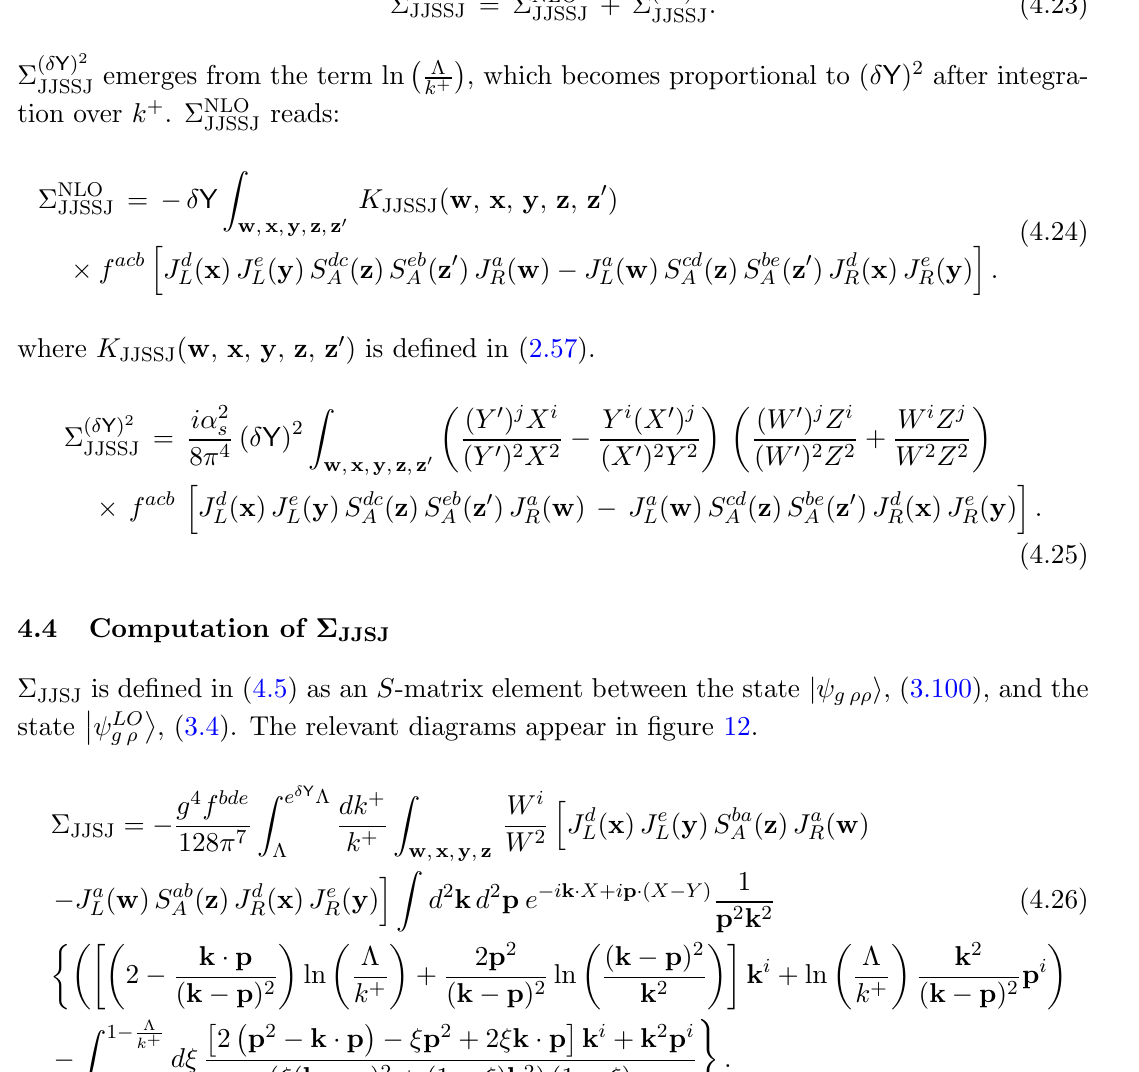
It is important to notice that J